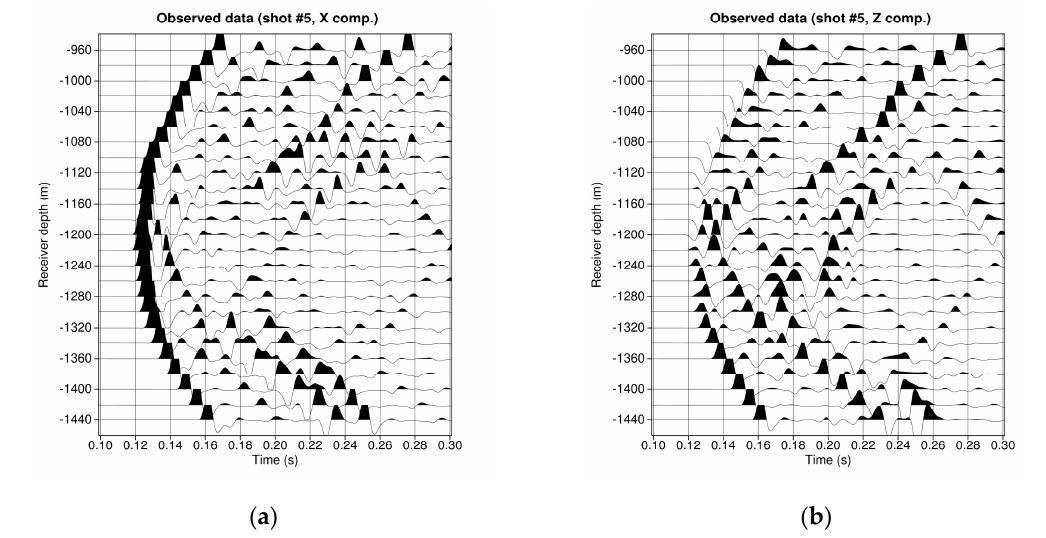
Figure 5. The 5th shot, at 1200 m deep, of the observed data obtained by full-wave modeling from the reference models: ( a ) The horizontal component; ( b ) the vertical component. The source function is a first derivative of a Gaussian with a central frequency of 100 Hz and it acts as a stress source with the following radiation coefficients σ xx = 1 , σ zz = 0.5, σ xz = 0. These data are used as observed data in